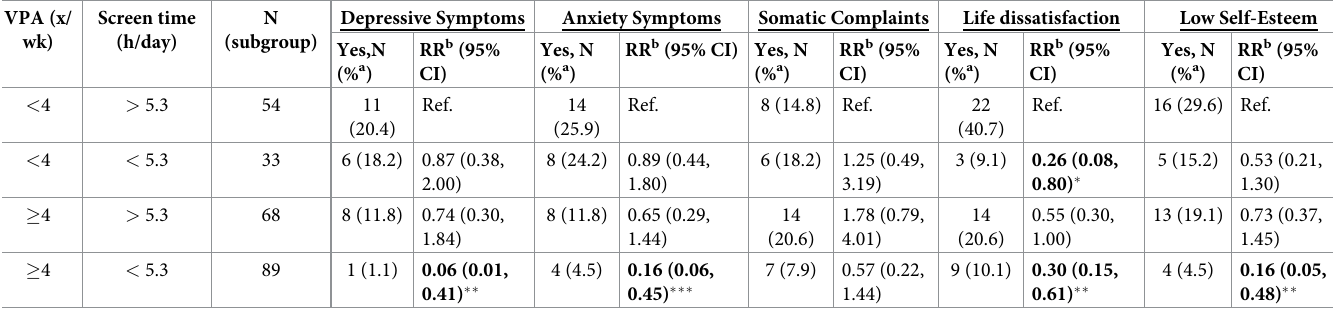
Table 4. Interactive effects of screen time and vigorous PA on mental health. VPA (x/